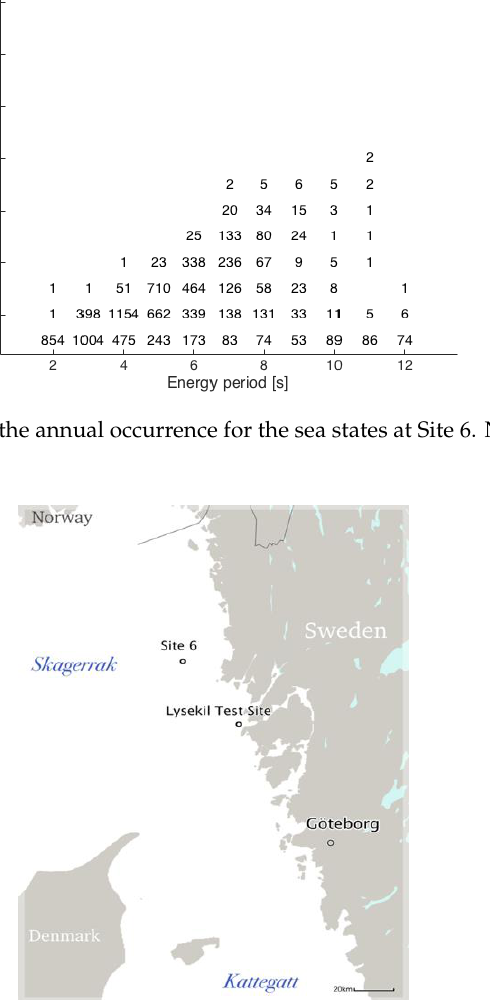
Figure 3. Map presenting the locations of the studied sites. In the study, the data for wave climates at Site 6 were utilized.